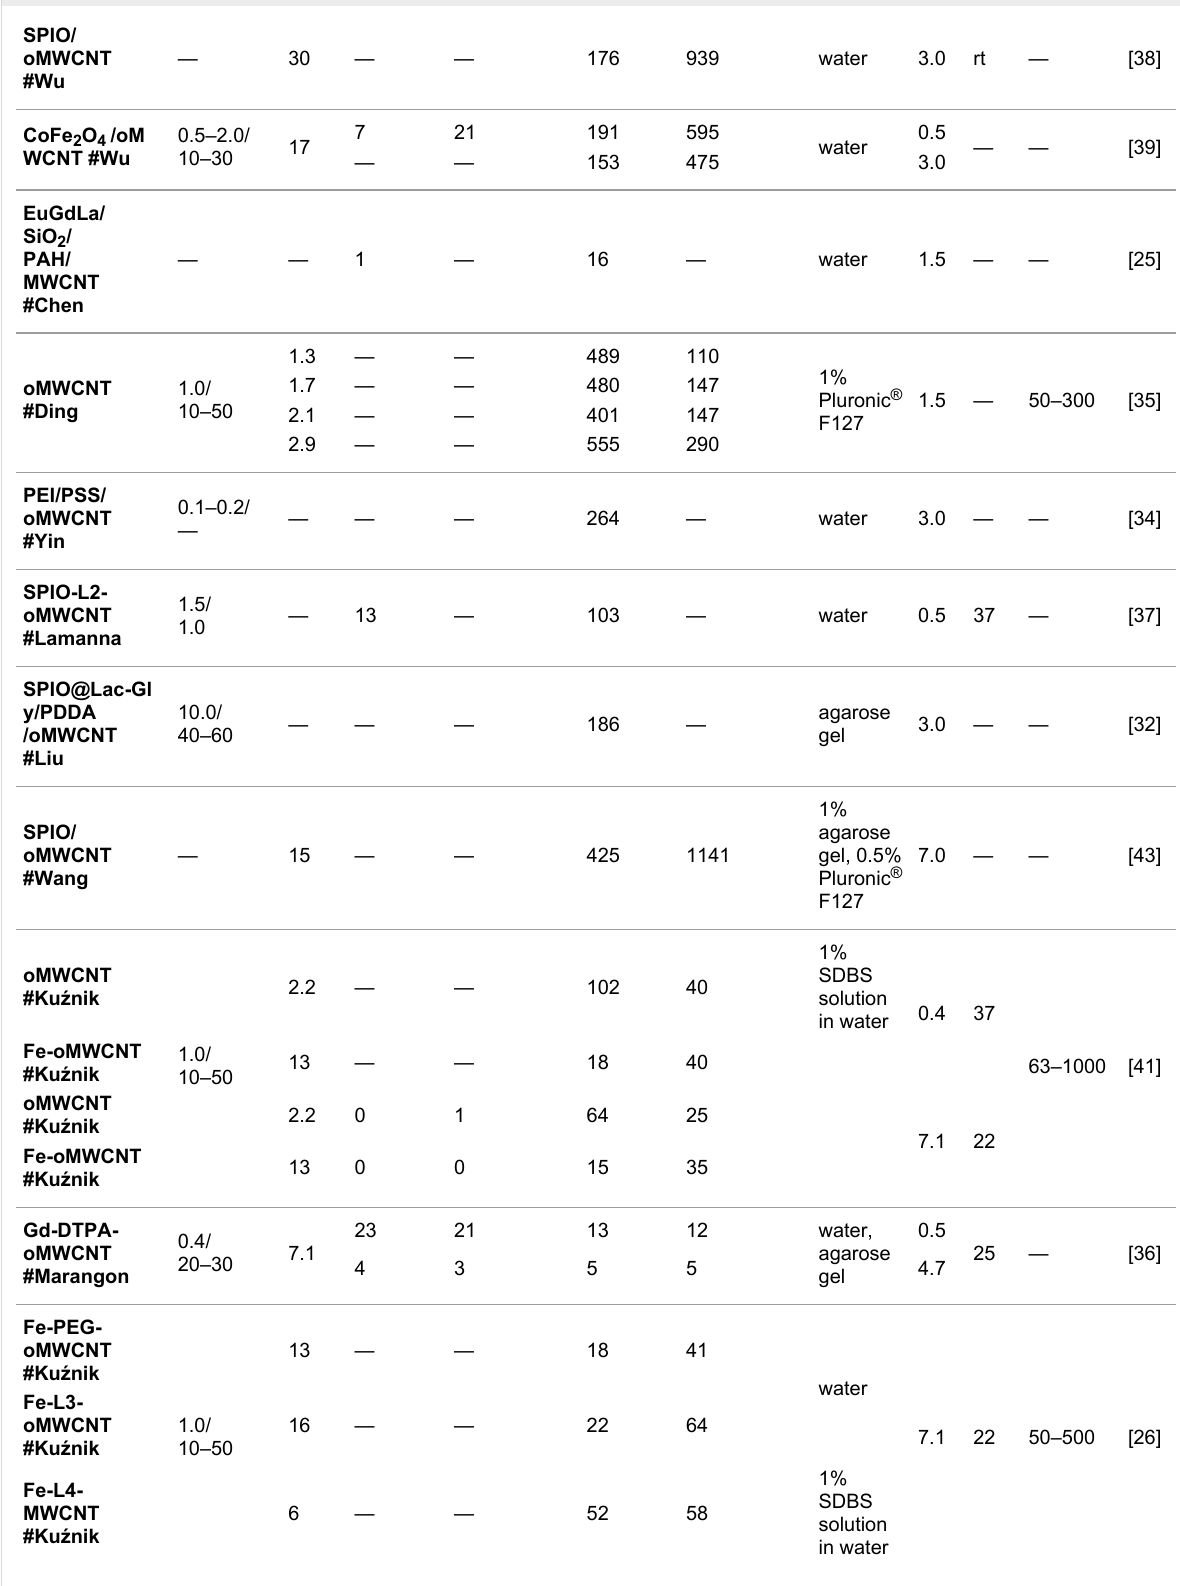
Table 1: In vitro relaxivity of MWCNT hybrids. a (continued) SPIO/